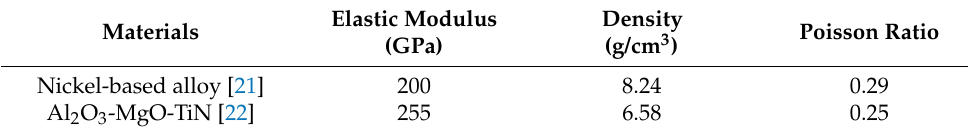
Table 1. Properties of reference nickel-based alloy and non-metallic inclusion.